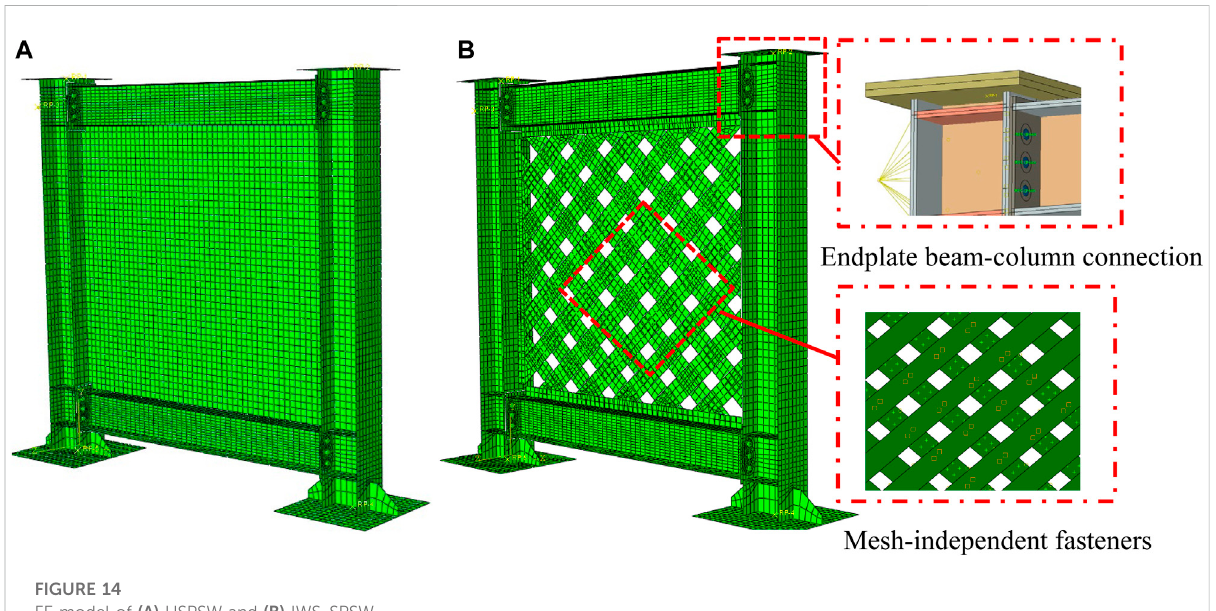
FIGURE 14 FE model of (A) USPSW and (B) IWS-SPSW.